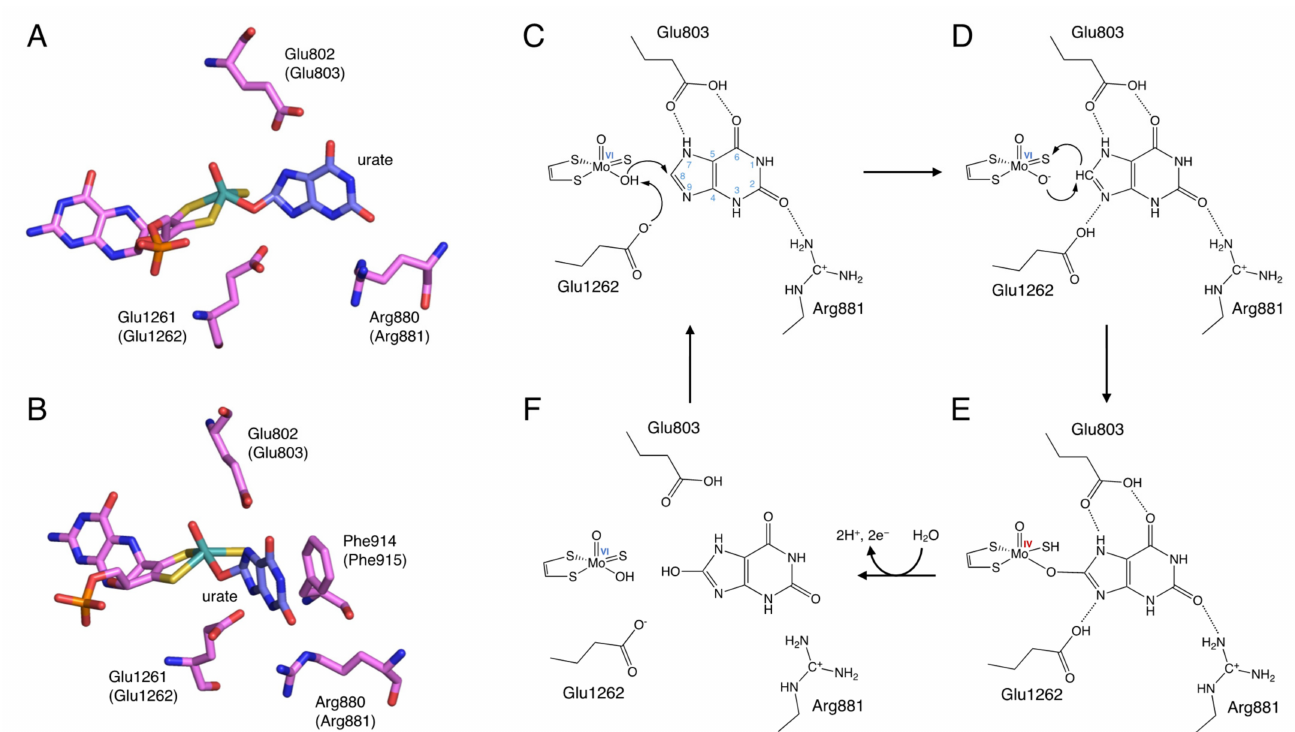
Figure 3. Binding mode of uric acid to XOR and hydroxylation mechanism of xanthine to uric acid. ( A , B ) Crystal structures urate bound to XOR (PDB ID: 3AMZ). ( C – F ) Scheme of hydroxylation of xanthine to uric